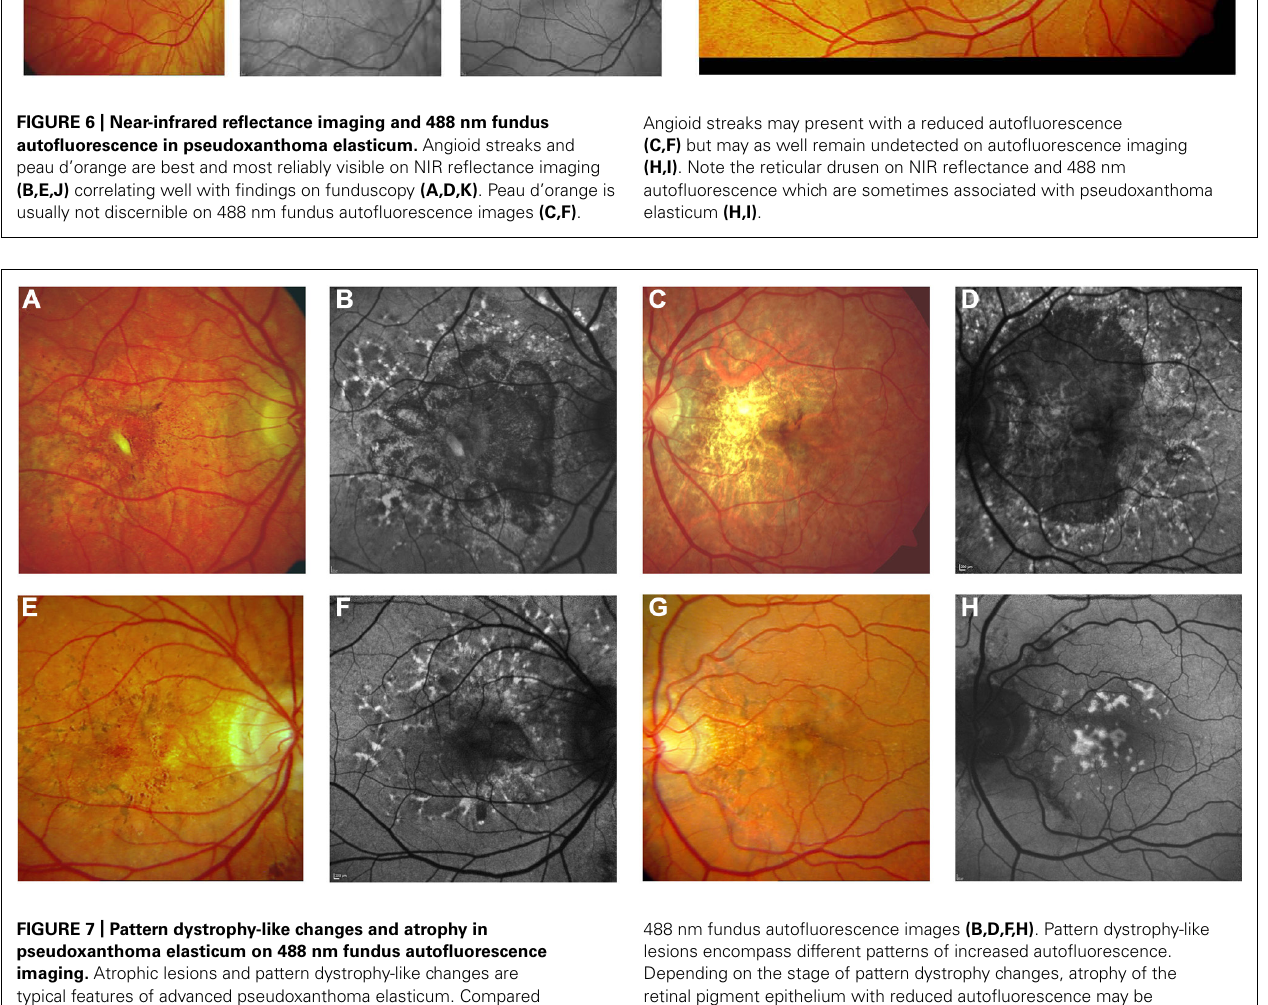
488 nm fundus autofluorescence images (B,D,F,H) . Pattern dystrophy-like lesions encompass different patterns of increased autofluorescence. Depending on the stage of pattern dystrophy changes, atrophy of the retinal pigment epithelium with reduced autofluorescence may be present (B,D,F)